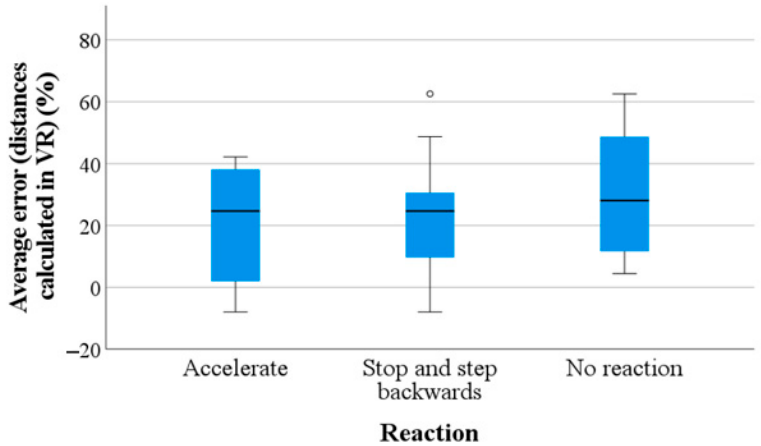
Figure 9. Boxplot chart of “Average error of distances calculated in VR” filtered by Event.